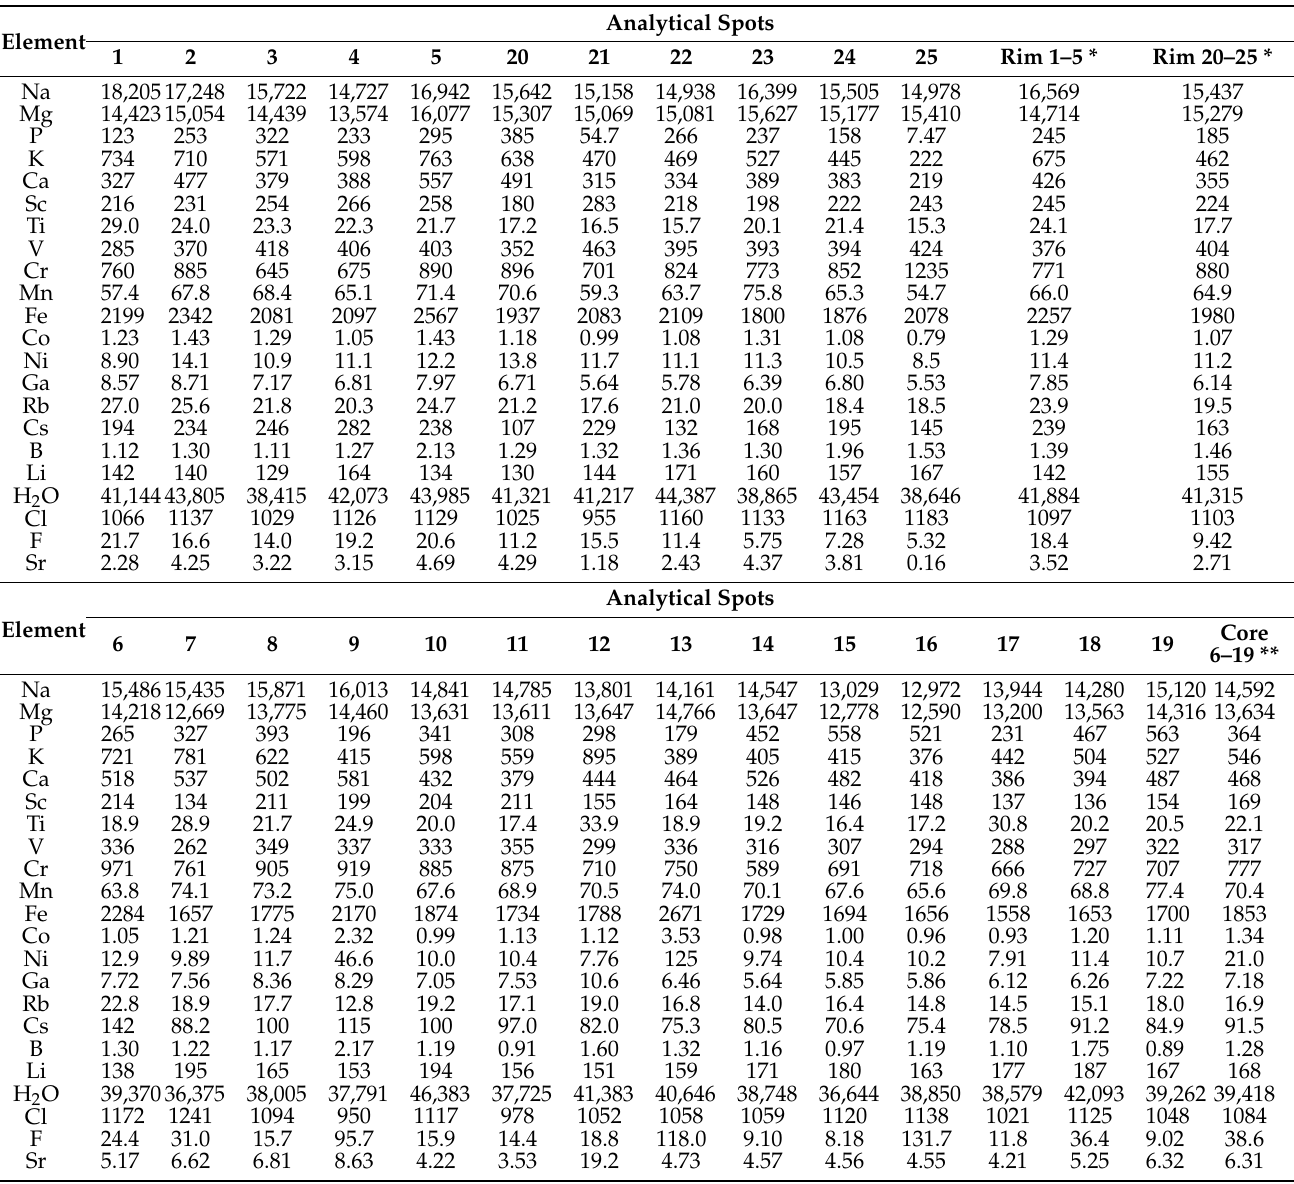
Table 1. Representative trace and minor element concentrations (ppm) in the analyzed beryl from Wadi Nugrus, South Eastern Desert,